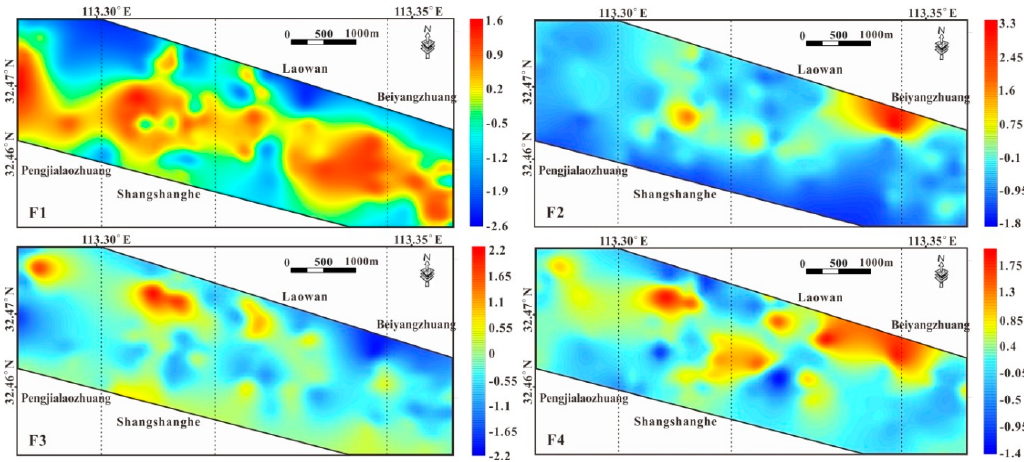
Figure 8. Factor score in the study area (F1: Cu–Co–Ni–V–Fe; F2: Au–Ag–Cu–As–Sb–S; F3: Bi–F–Mo– Sn; F4: Pb–Zn). F4: